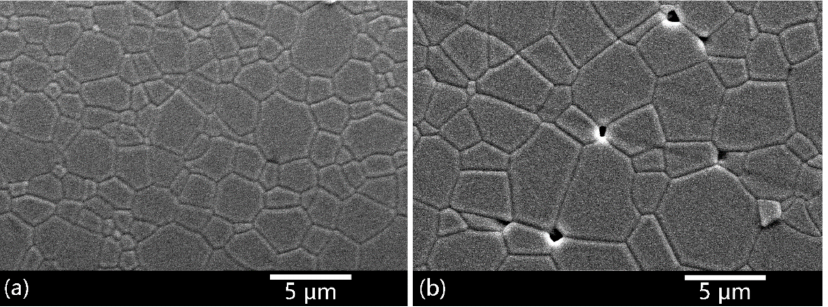
Figure 4. SEM images of the ceramics after vacuum sintering 1550 ◦ C and HIP-ing at 1510 ◦ C with CaO concentration of ( a ) 0.02 wt.% and ( b ) 0.15 wt.%.